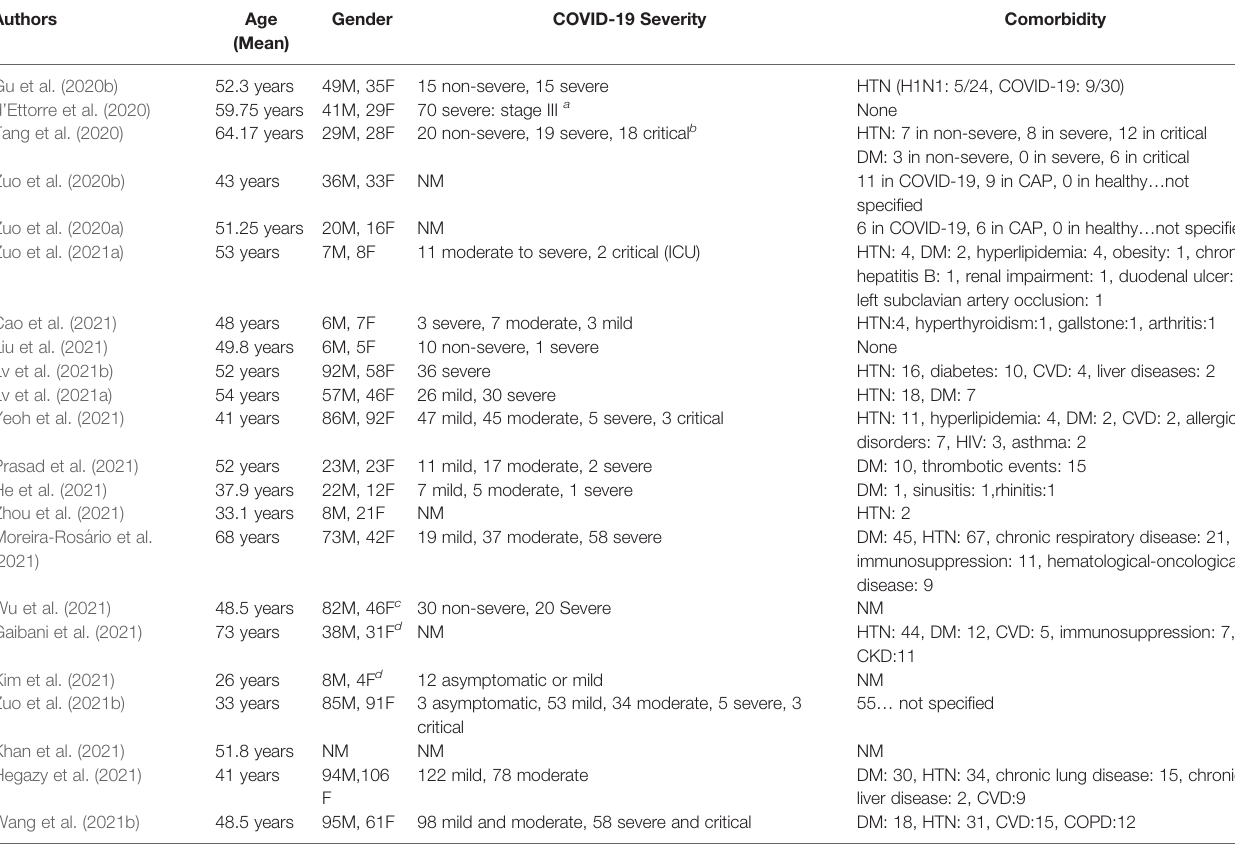
TABLE 2 | Characteristics of the study